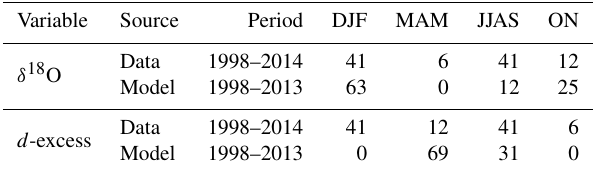
Table 6. Fraction of annual maxima (%) of δ 18 O and d -excess iden- tified during each season: austral summer (DJF, i.e. from December to February), austral autumn (MAM, i.e. from March to May), aus- tral winter (JJAS, i.e. from June to September), and austral spring (ON, i.e. from October to November) in the data over the period 1998–2014 and in the ECHAM5-wiso simulation (model) over the period 1998–2013. The analysis is based on resampled data (ice core) and monthly values